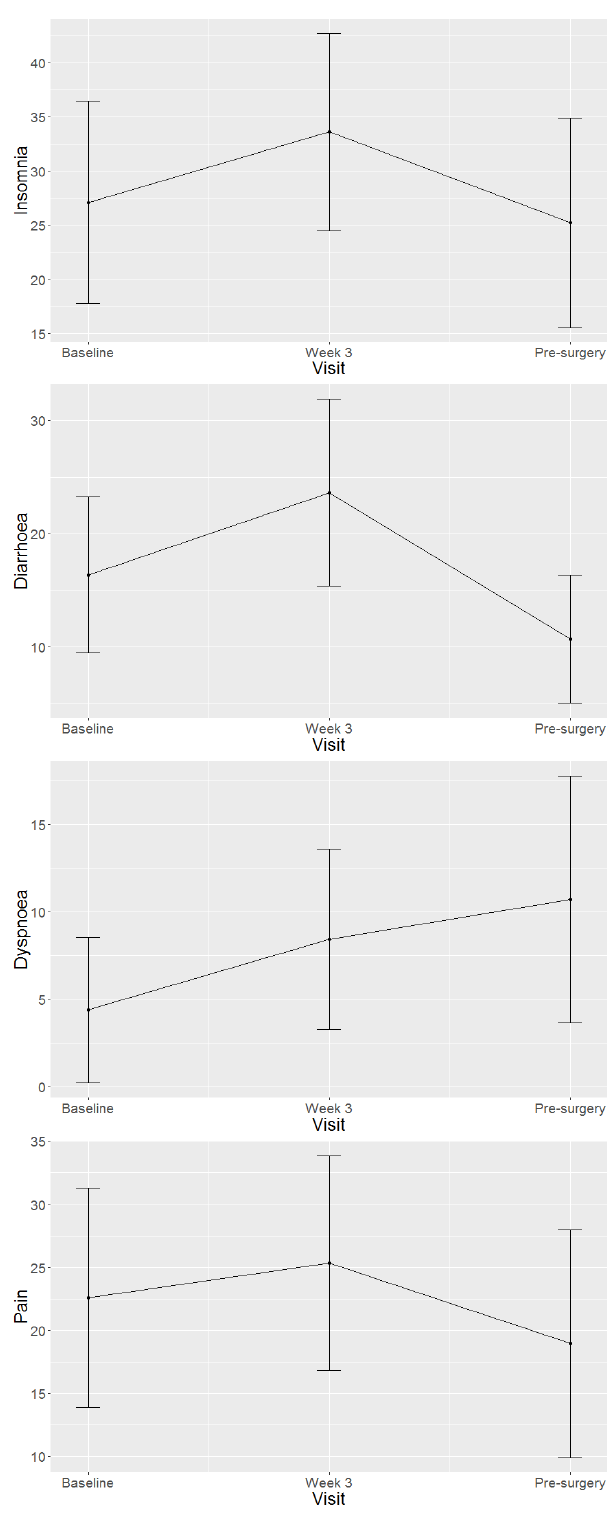
Figure 1. Figure 1. Cont.